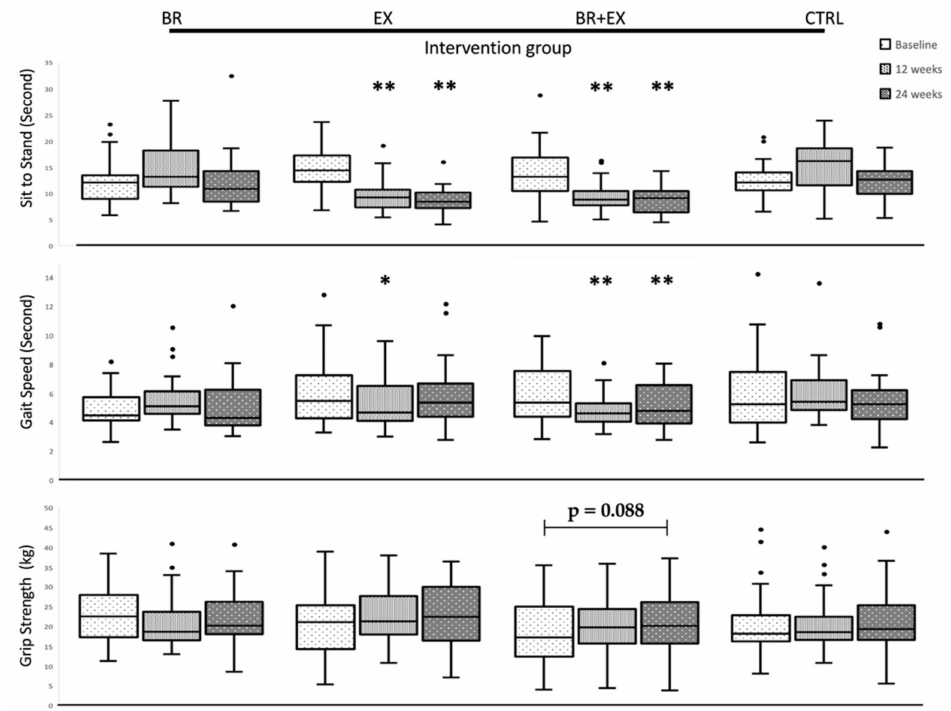
Figure 4. Changes in Sit to Stand (Upper), Gait Speed (Middle) and Grip Strength (lower) in all 4 di ff erent intervention groups during the 24-week intervention period (BR = Black rice germ and bran alone group, EX = Exercise alone group, BR + EX = Combined group, and CTRL = Control group) * p < 0.05, ** p < 0.001 vs. baseline with statistical significance using Friedman